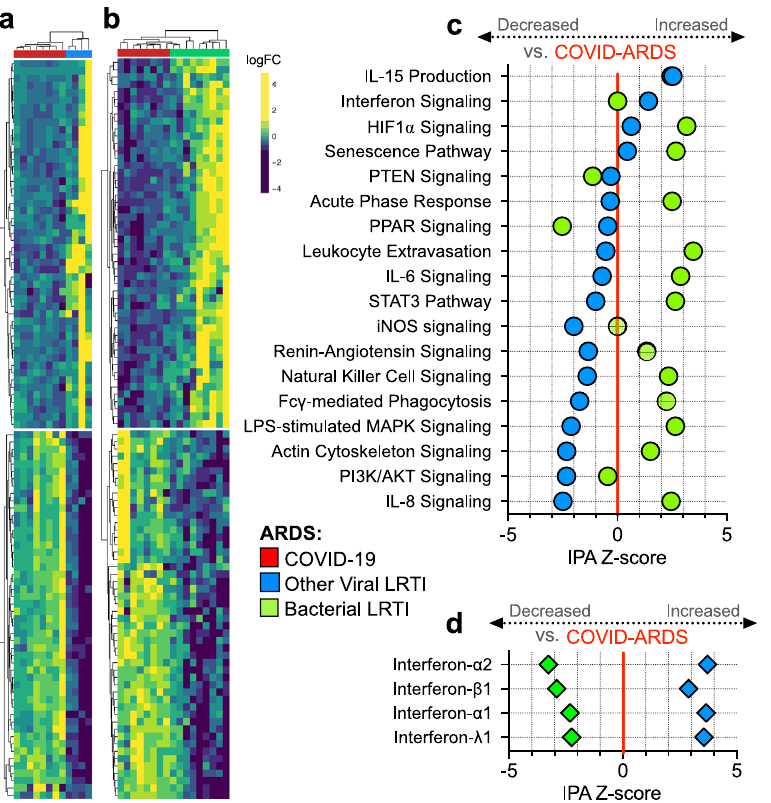
Fig. 3 Lower respiratory tract transcriptional signature of ARDS due to COVID-19 versus other viral or bacterial lower respiratory tract infections. a Heatmap depicting expression and unsupervised clustering of top differentially expressed genes by adjusted P value between patients with COVID-19- related ARDS (COVID-ARDS, red) versus ARDS due to viral LRTI (Viral-ARDS, blue). b Heatmap depicting z-scaled expression and unsupervised clustering of the top 50 differentially expressed genes between patients with COVID-19-related ARDS (COVID-ARDS, red) versus ARDS due to bacterial LRTI (Bacterial-ARDS, green). c Pathway analysis based on differentially expressed genes depicting relative expression of signaling pathways by IPA Z- score with respect to a baseline of gene expression in COVID-ARDS. Values are tabulated in Supplementary Data 6. d Predicted activation of upstream interferons in patients with ARDS due to viral or bacterial LRTI compared to those with COVID-ARDS revealed downregulation of type-I/III interferons in COVID-ARDS versus other viral LRTI-related ARDS. Values tabulated in Supplementary Data 9. Source data are provided in the Source Data fi